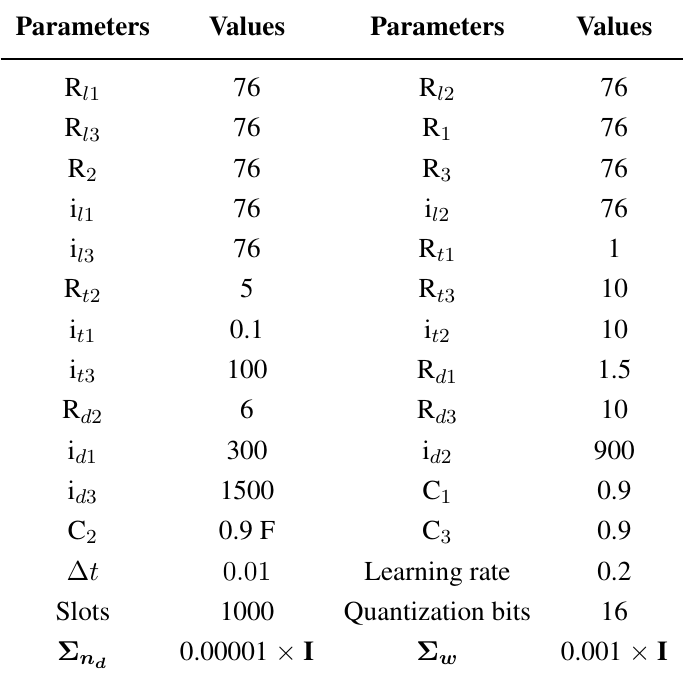
Table 1. The system parameters (Ohm and Amp) for simulations.